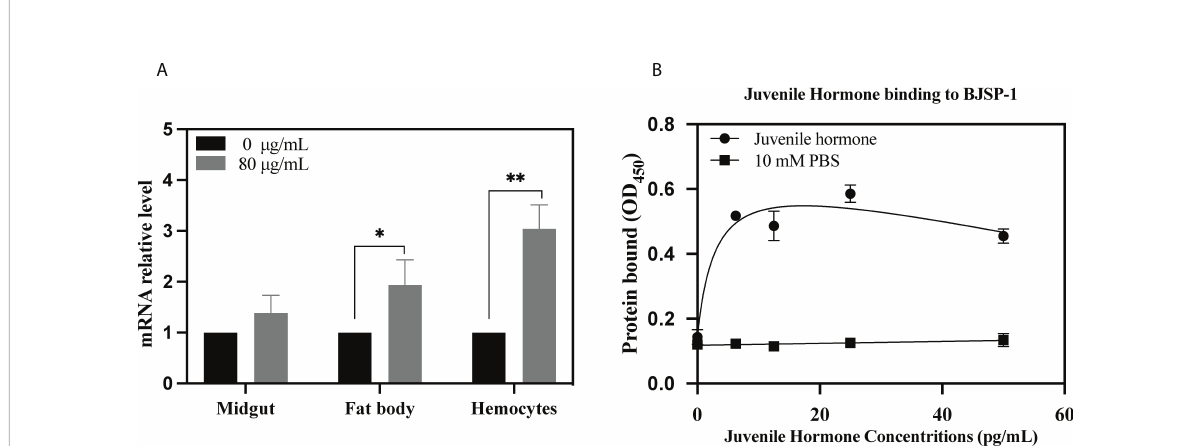
FIGURE 5 Feeding Cry7Ab4 toxin upregulated the BJSP-1 mRNA level in the hemocytes and fat body of P. xylostella larvae, and BJSP-1 bound to free JH. (A) P. xylostella larvae (fourth-instar day 2) were fed a diet containing Cry7Ab4 toxic core for 24 h, and the expression of BJSP-1 mRNA in the hemocytes, fat body, and midgut of larvae was determined by real-time PCR. Signi fi cant difference was determined by Student ’ s t-test between the control (0 m g/g of Cry7Ab4) and Cry toxin feeding groups (80 m g/g of Cry7Ab4), indicated by **( p < 0.01). (B) Microtiter plates were coated with recombinant BJSP-1-GST, increasing concentrations of free JH were added to BJSP-1-coated plates, and binding of JH to BJSP-1-GST was determined by ELISA assay and detected by horseradish peroxidase (HRP)-conjugated anti-JH antibody. *( p <